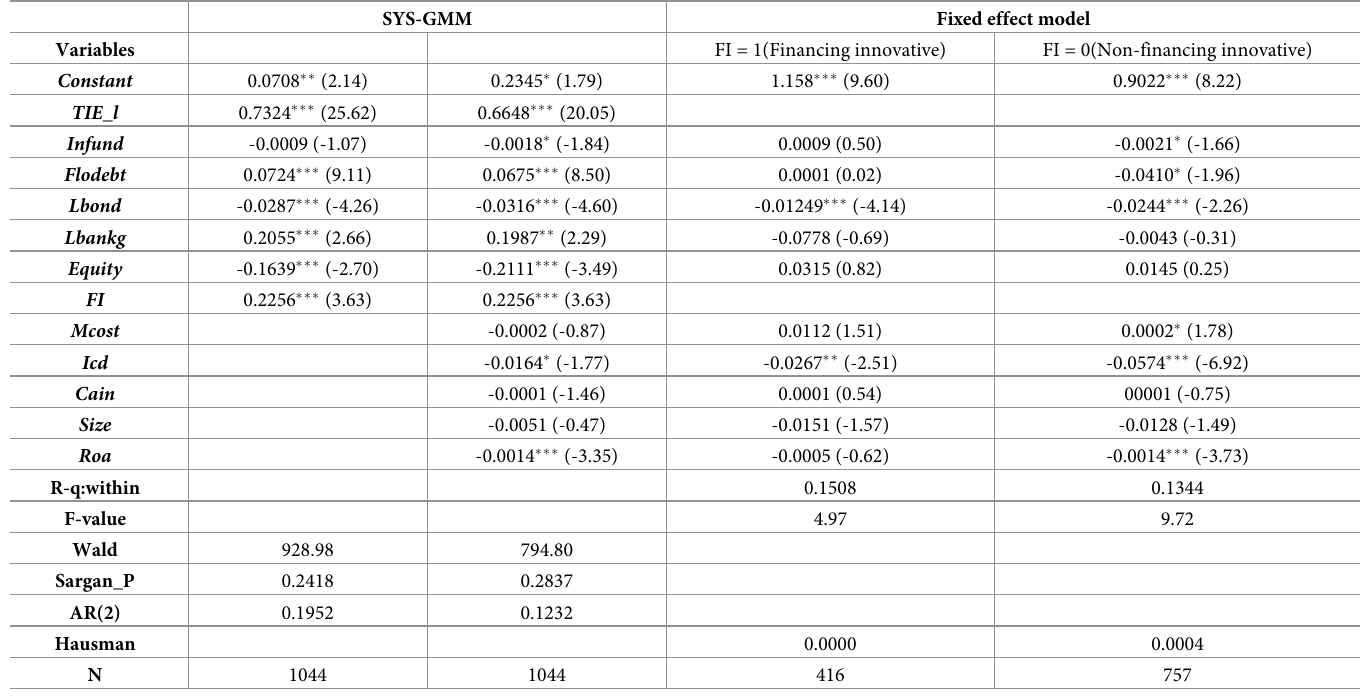
Table 11. Results of the fixed effect model and the SYS-GMM